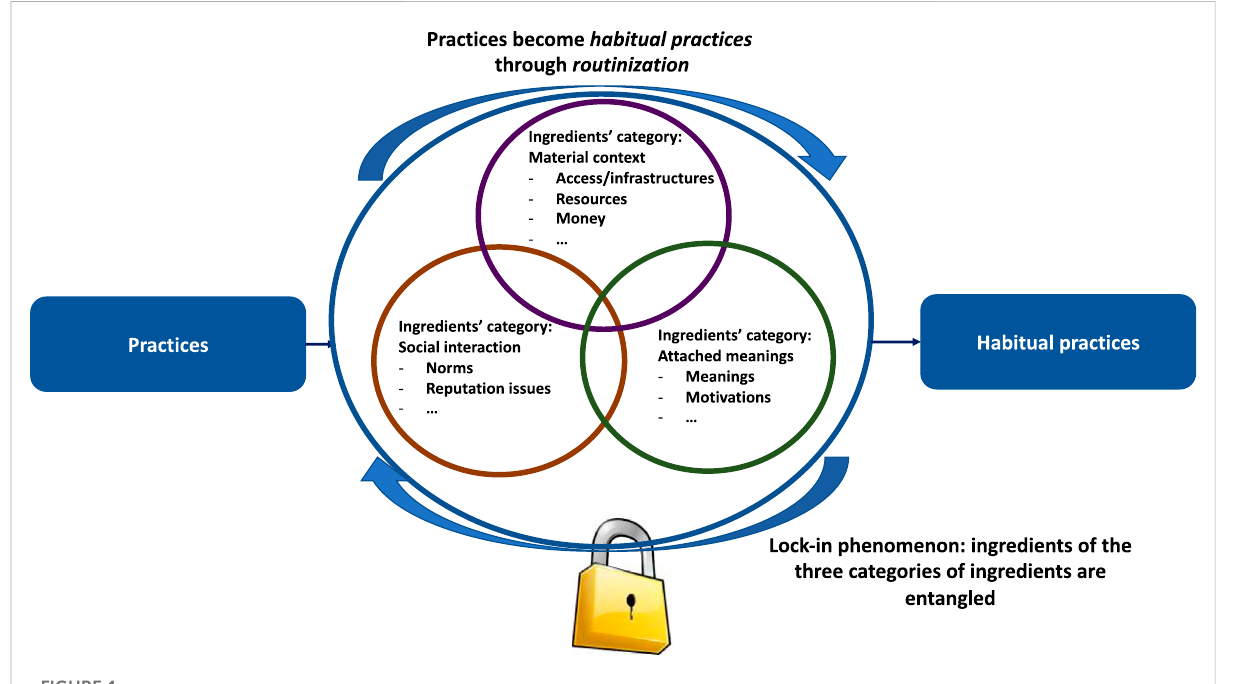
FIGURE 1 Conceptual scheme of locked-in habitual practices. Source: Authors ’ elaboration based on Maréchal and Holzemer (2015,